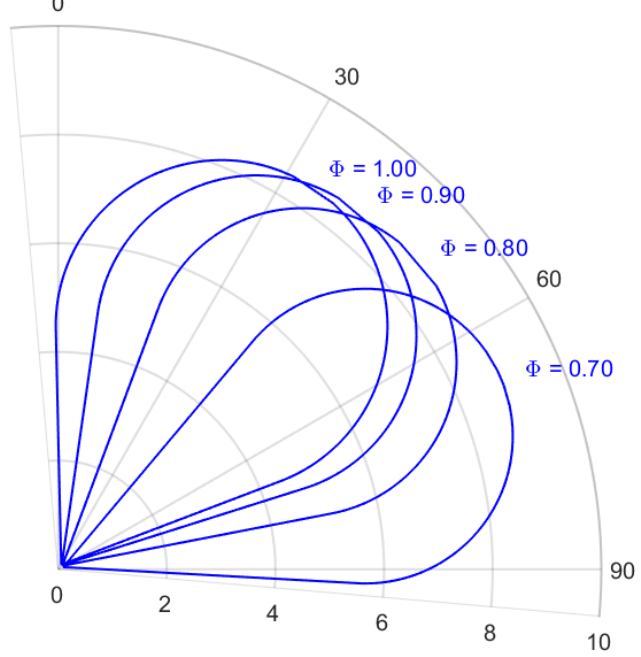
Figure 11. Blow-down chart for varying fill ratios at a wind speed of 4 m/s. The blow-down angle β [ ◦ ] is measured between plumbline and the lower (here right side) limb of the hull. The radial extent of the hull is given in [m].